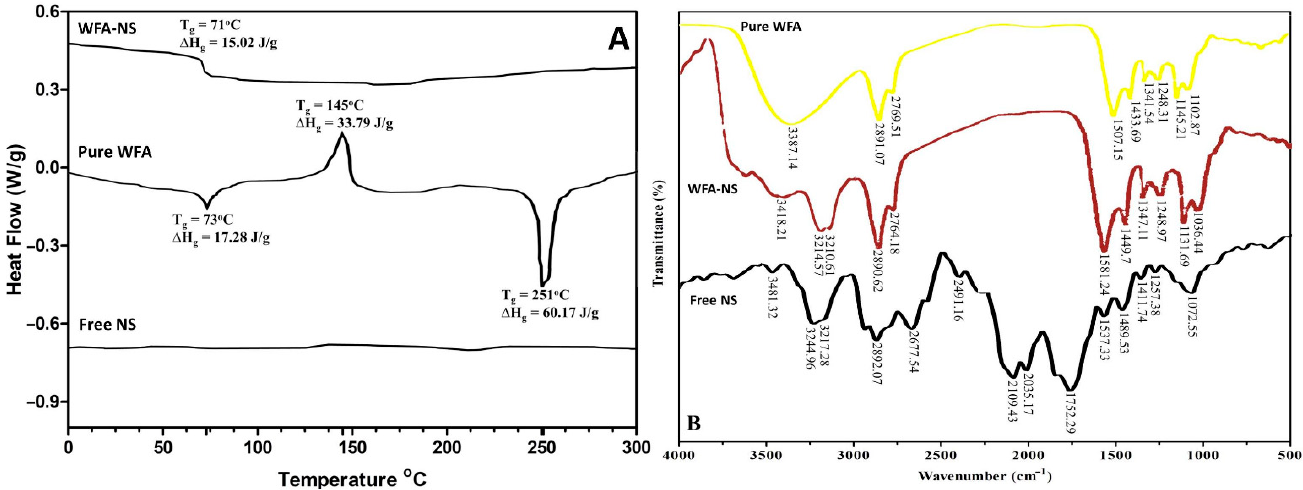
Figure 1. The representation of DSC thermogram of WFA-NS, pure WFA, and free NS ( A ), and FTIR spectra of pure WFA, WFA-NS and free NS ( B ).